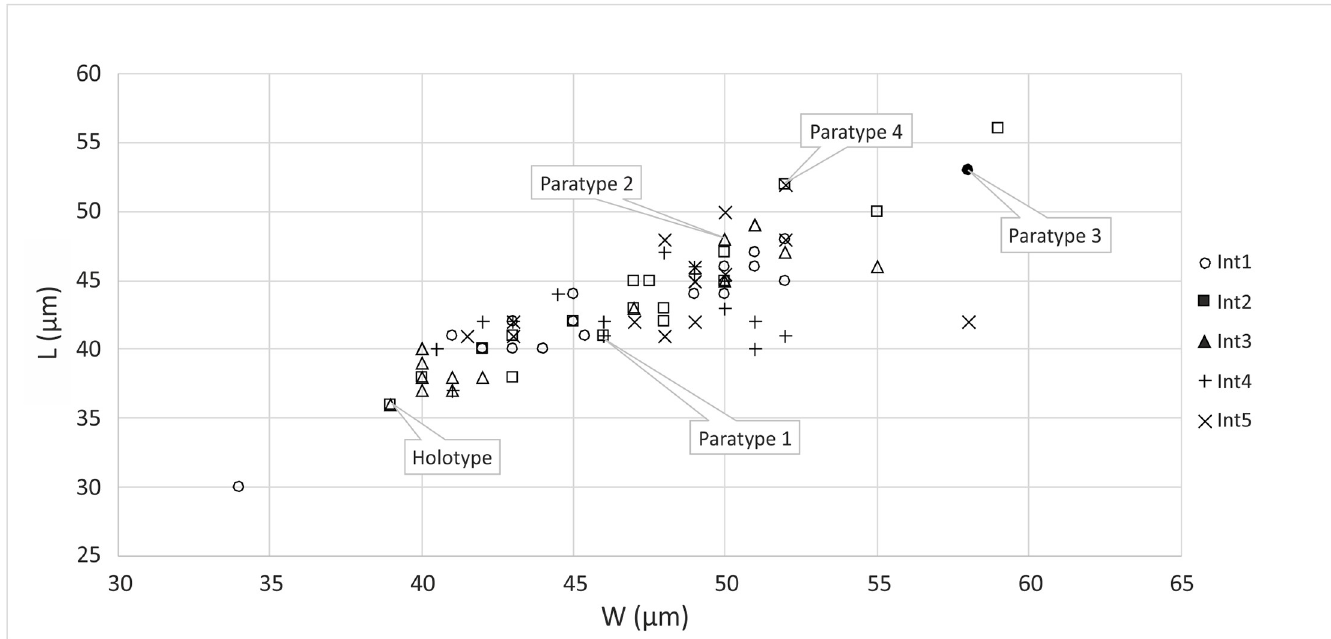
Fig 7. Diagram representing the relation between the length (L) and width (W) of Cadosinopsis rehakovii sp. nov., based on data from Table 1. Int 1—Int 5 – intervals separated on the studied thin section no, Szel 21b. Thin sections no: Szel 21a and Szel 21b.